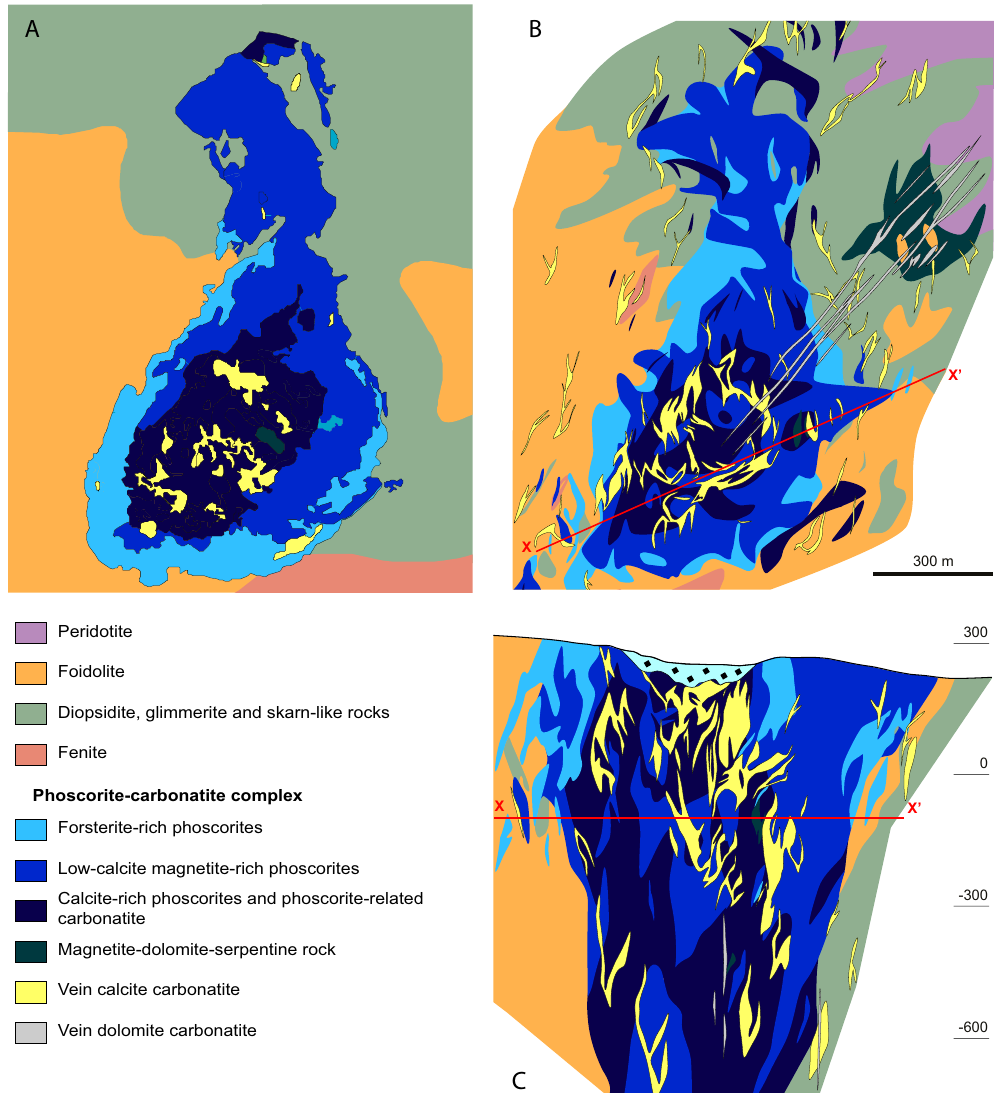
Figure 8. Manually created maps and cross-section of the Kovdor magnetite-apatite-baddeleyite deposit: ( A ) by geological service of JSC “Kovdorskiy GOK” 15 , level ≈− 60 m; ( B , C ) by P.M. Goryainov and colleagues 13 , level − 100